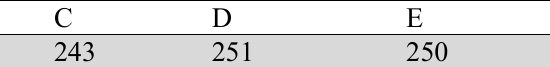
Number of perfect days